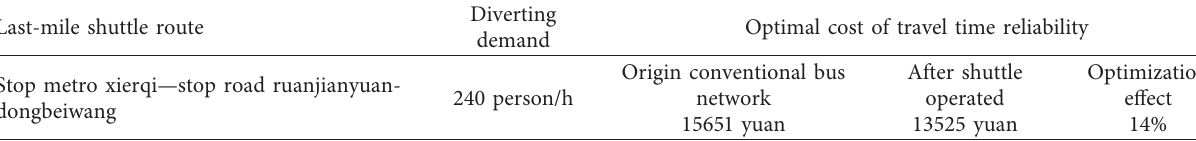
Table 8: Optimization